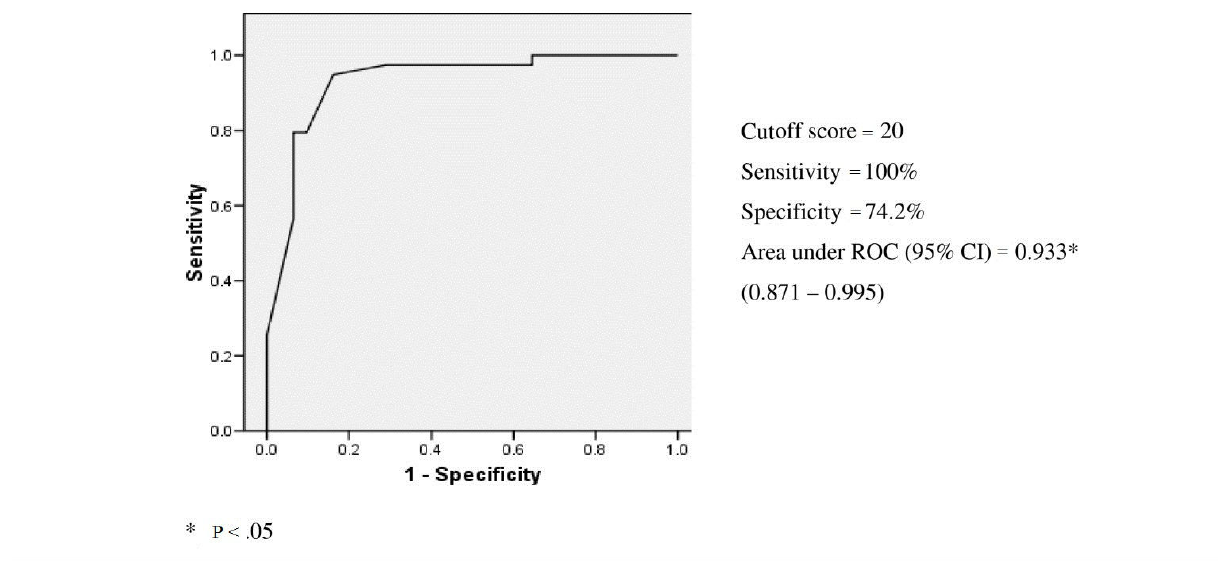
Figure 3. Receiver-operating curve (ROC) for the Virtual Reality Day-Out Task (VR-DOT) total score when discriminating among nondemented (healthy controls), amnestic mild cognitive impairment (aMCI), and patients with mild Alzheimer-type dementia (mild AD).